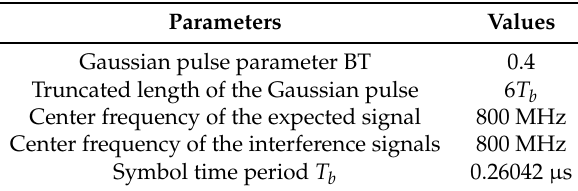
Table 2. Simulation Parameters.